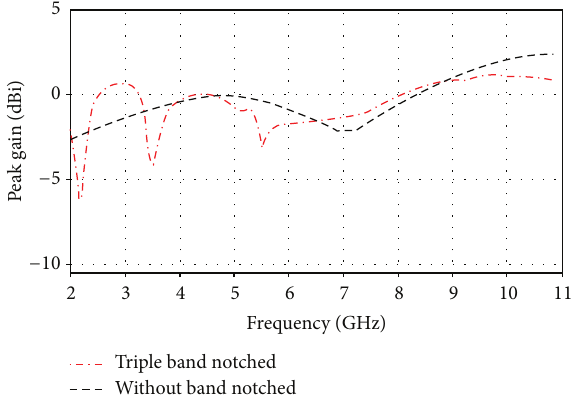
Figure 11: Peak gain of the proposed antenna with and without notched band